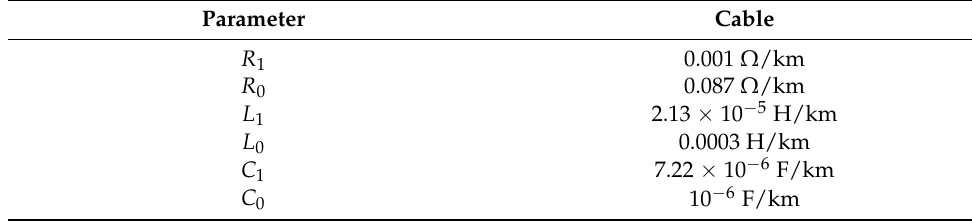
Table 3. Transmission-line parameters of the underground